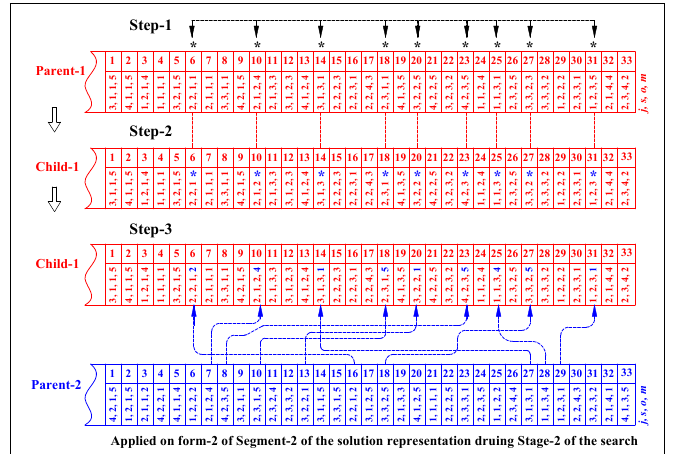
Applied on form-2 of Segment-2 of the solution representation druing Stage-2 of the search Figure 8. Illustration of the MAC crossover operator (the asterisks * denote the locations of arbitrarily selected